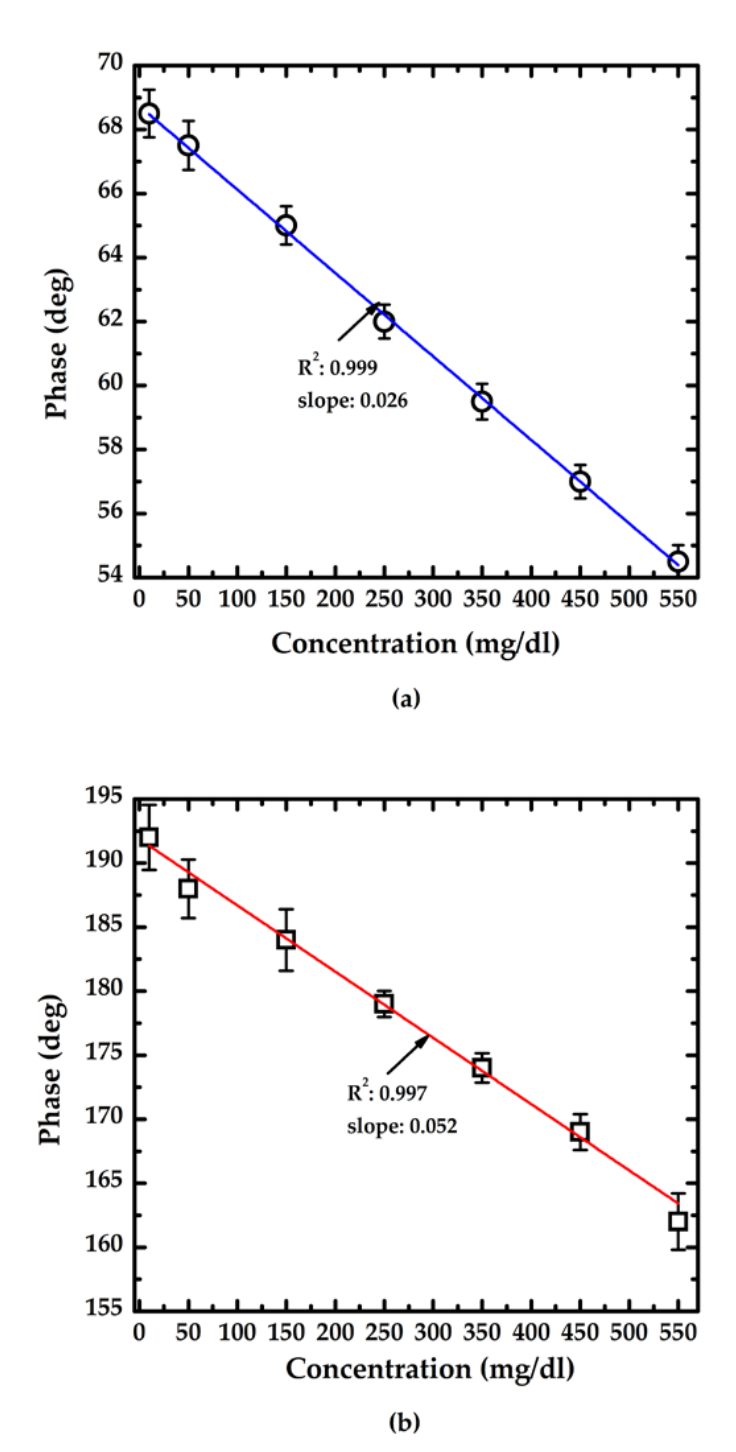
Figure 8. The calibration curves of the proposed method: ( a ) the sensor with length of 1 cm; ( b ) the sensor with length of 3 cm.